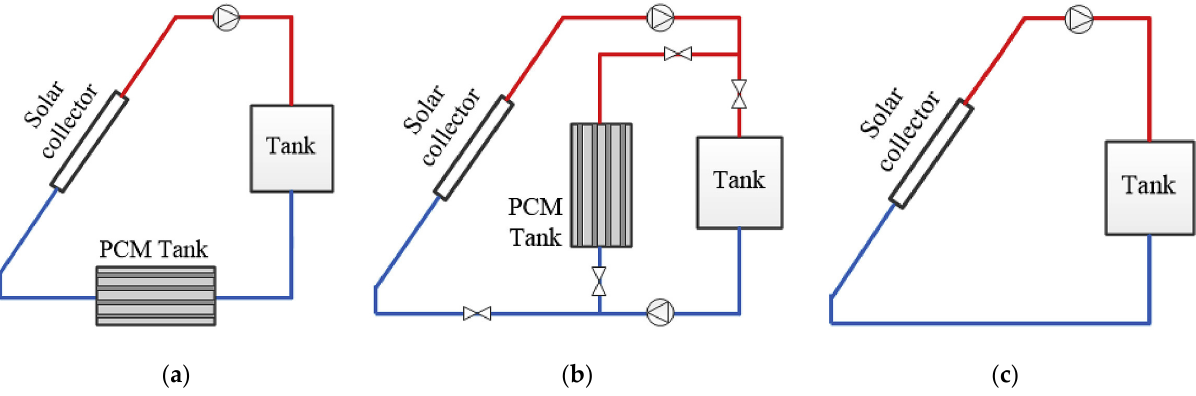
Figure 16. ( a ) Series ( b ) parallel and ( c ) single tank systems examined in [52].